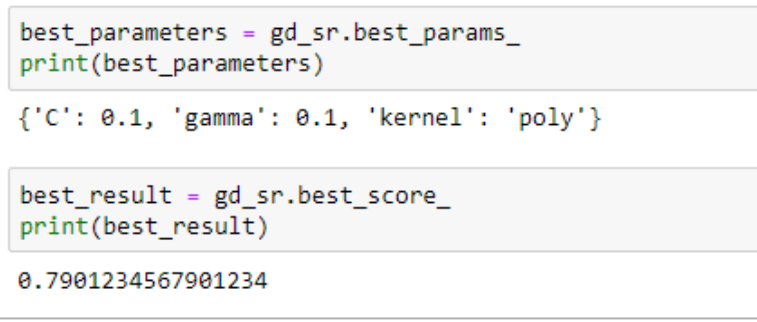
Figure 32. The best parameters with obtained after performing grid search with 10-Fold Cross- Validation on the SVM-Poly model.